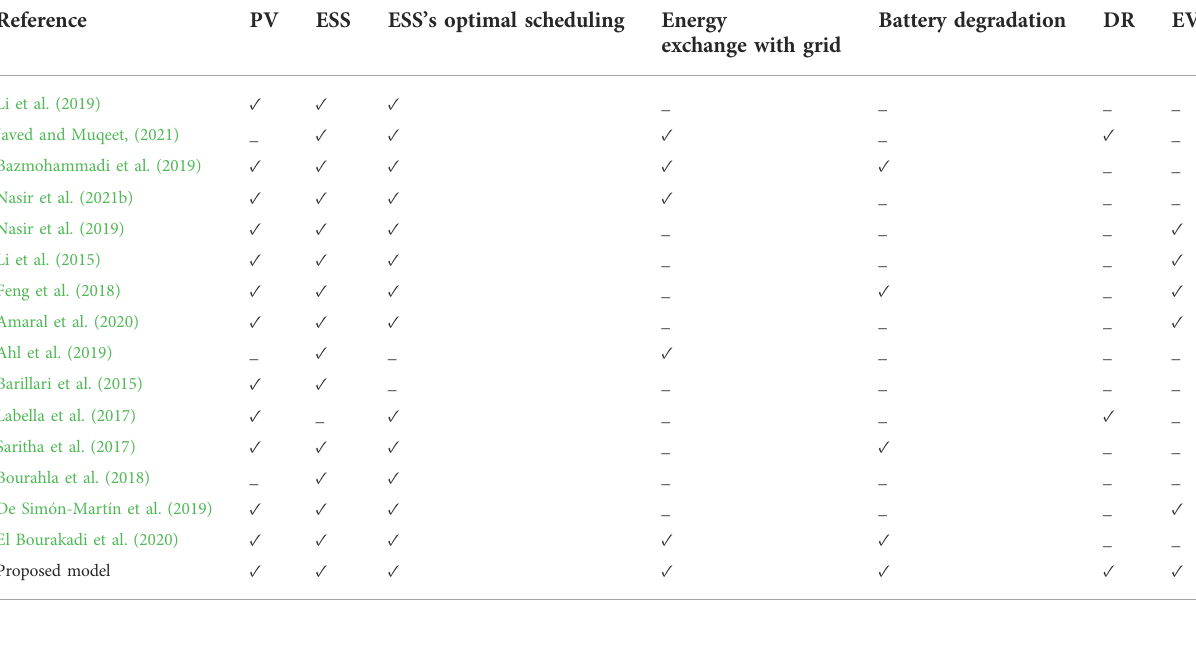
TABLE 1 Comparison summary of approaches.